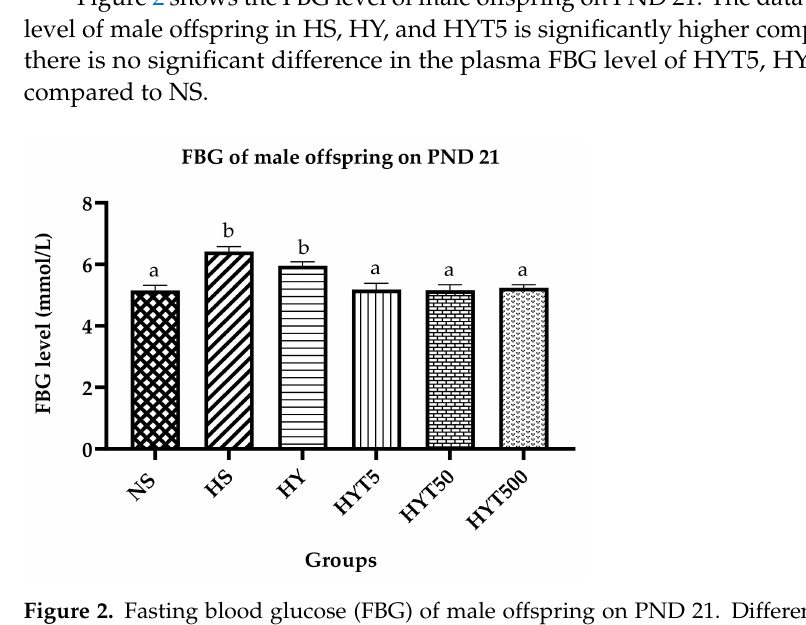
Figure 2. Fasting blood glucose (FBG) of male offspring on PND 21. Different letters indicates a significant difference at p < 0.05.